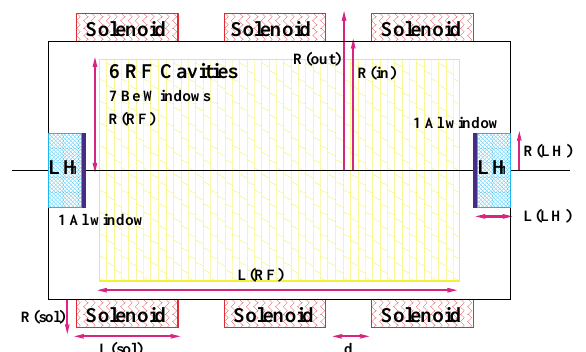
FIG. 8. (Color) Single flip cooling cell layout.